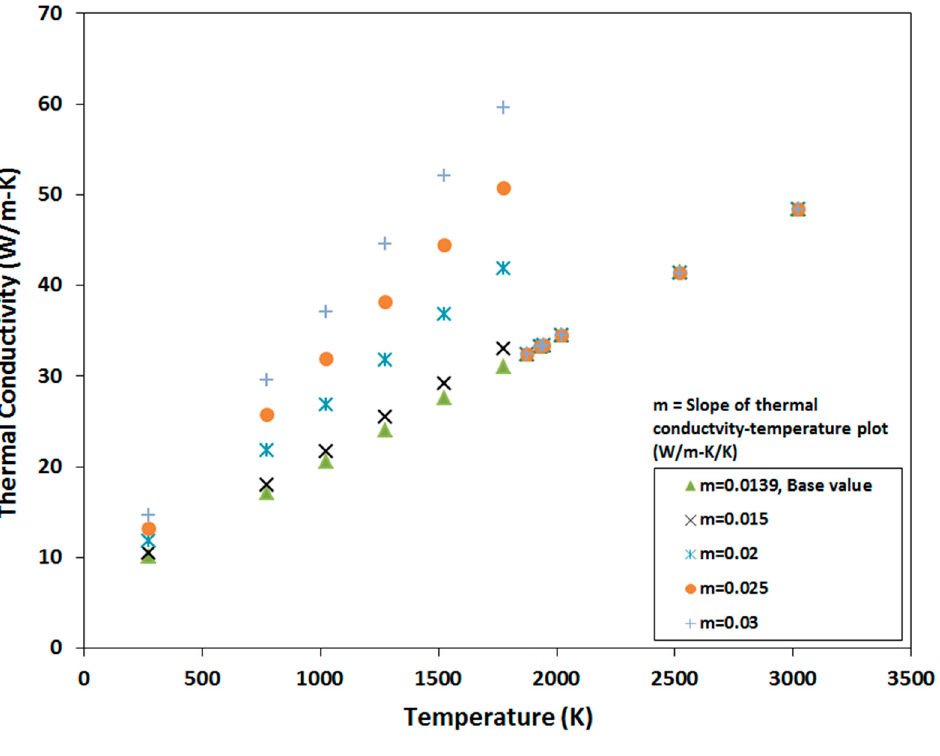
Figure 11. Slope of thermal conductivity data before melting point is varied.